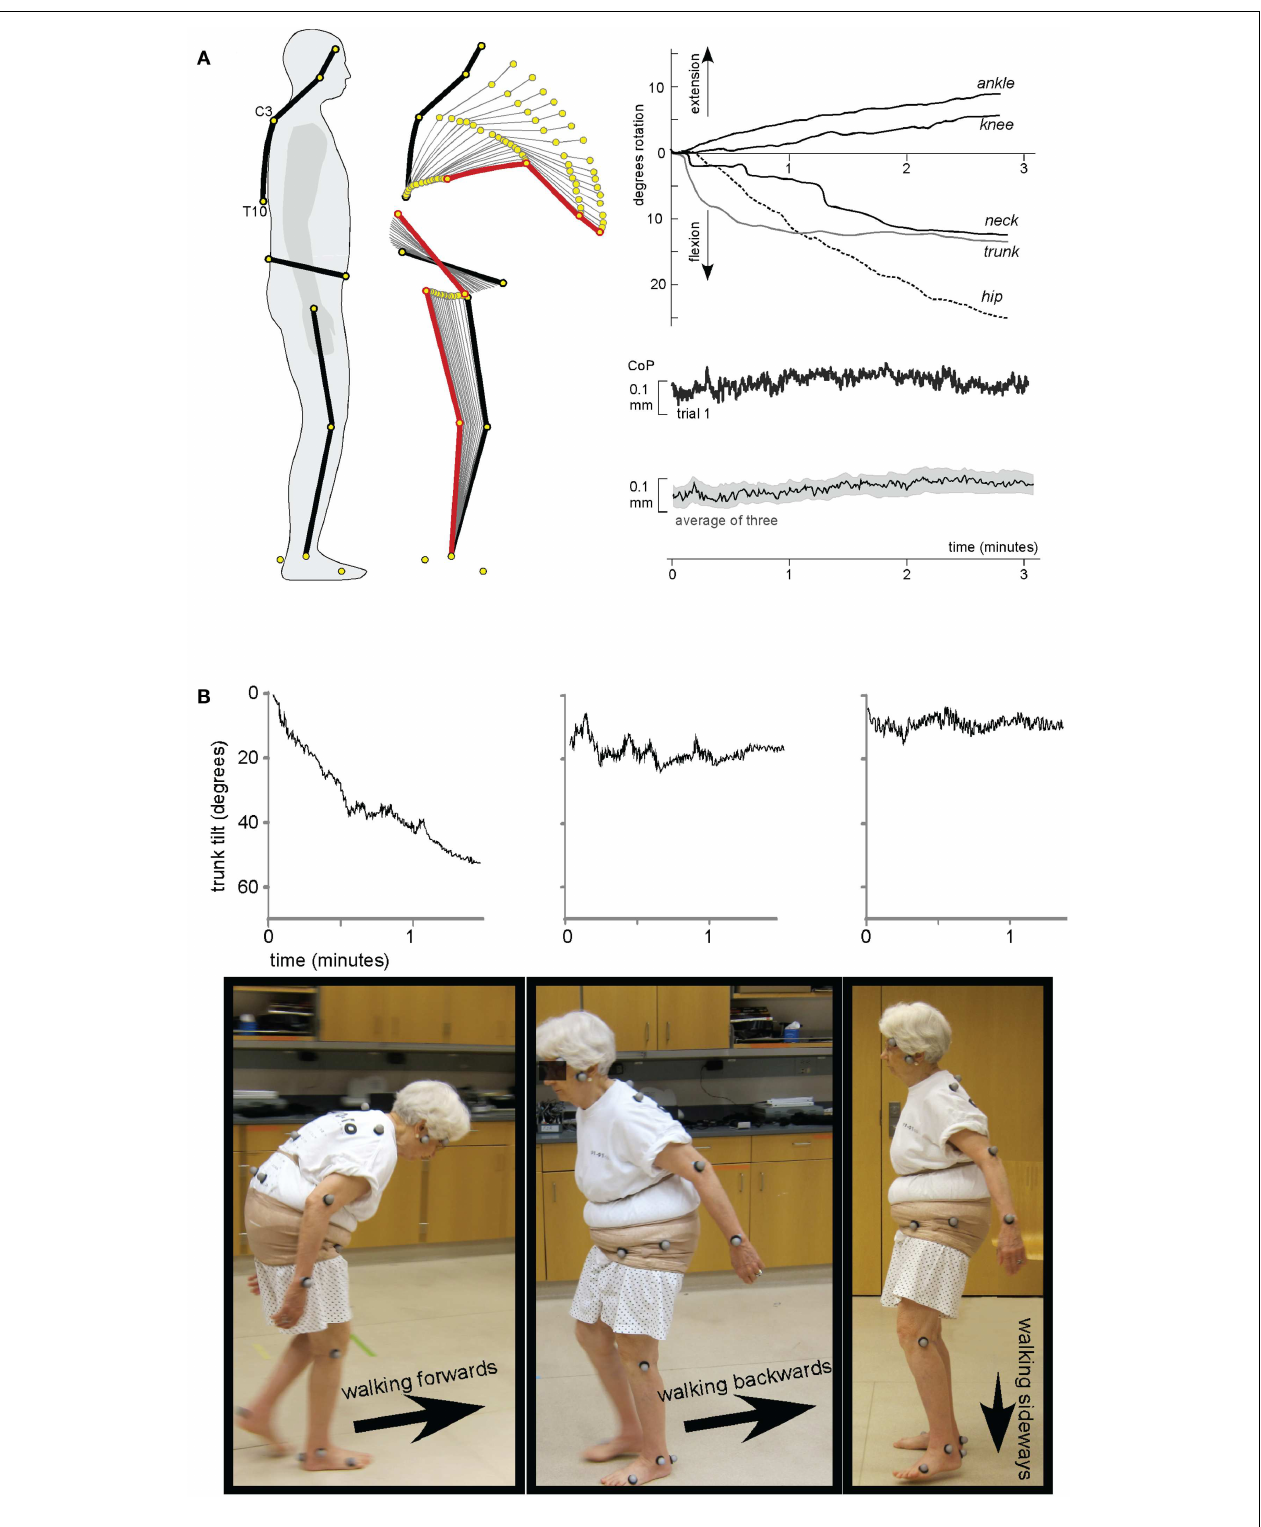
coordinated way that ensures that the center of pressure remains steady over the base of support. (B) Trunk flexion when walking forward, but NOT when walking backward or sideways [the data were adapted from St George et al.